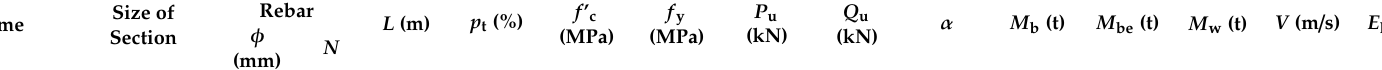
Table A1. Test specimens were used for